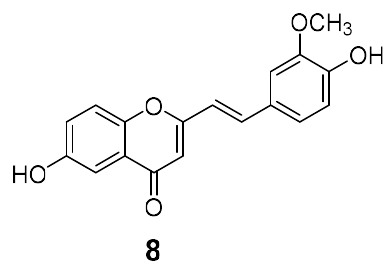
Figure 2. Structure of 2-(2-phenylethenyl)chromone identified in agarwood.